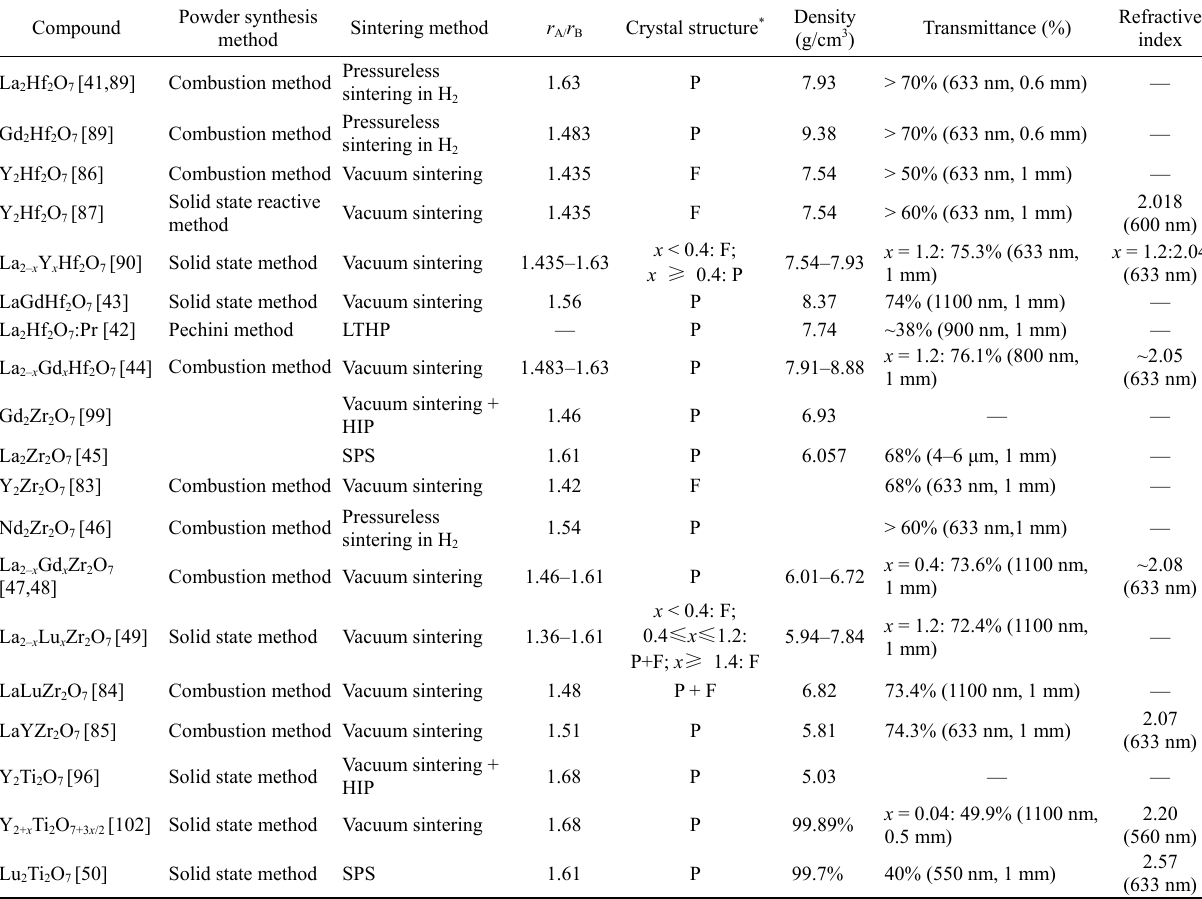
Table 1 Fabrication method and properties of the reported A 2 B 2 O 7 system transparent ceramics